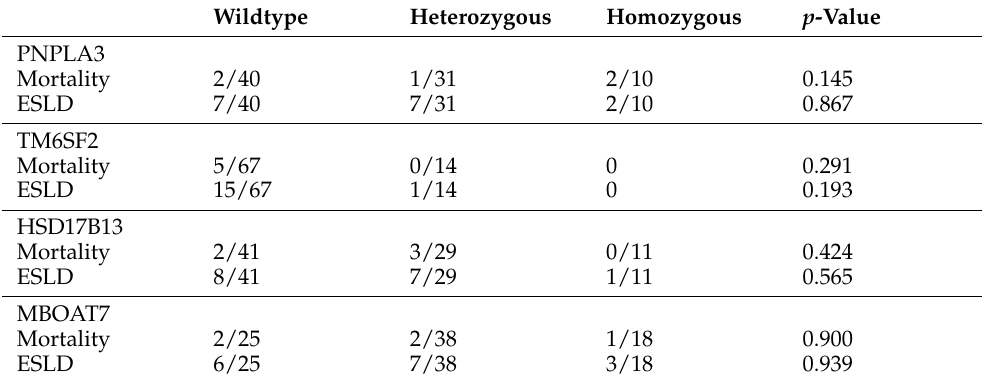
Table 2. Clinical endpoints according to different single-nucleotide polymorphisms.